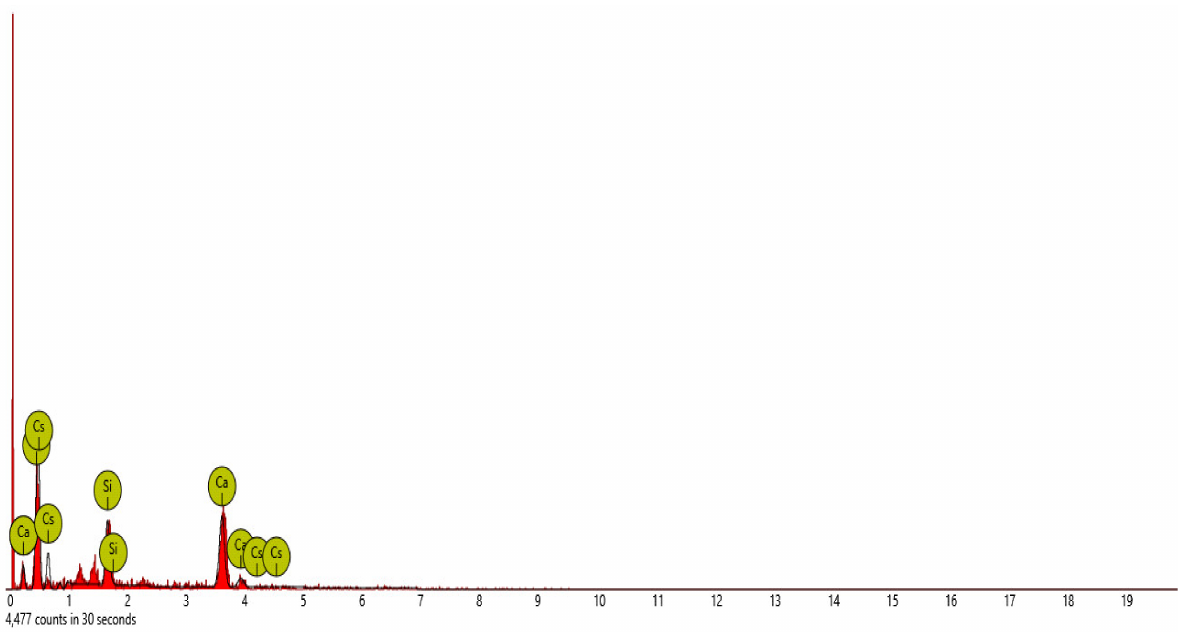
Figure 15. Graphical charts illustrating the atomic quantifications and weights of the elements discovered from the EDS spectra of pervious concrete spot 1 sample Y 1